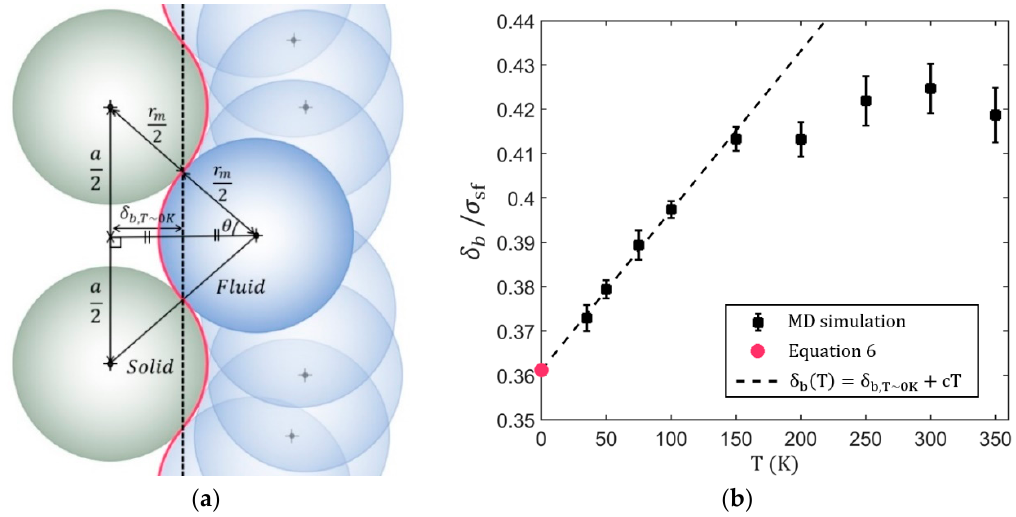
Figure 7. ( a ) A geometrical representation of solid / fluid boundary (red curve) near the absolute zero-temperature. Where r m is the location of the minimum LJ potential between solid and fluid (i.e., (cid:3117) r m = 2 1 6 σ sf ) and a is the lattice constant. ( b ) Determined Solid / fluid boundary with respect to the temperature for the Ag / He interface. The constant value of the linear fitting chosen as 3.6 × 10 − 4 for best fitting of first 4 data.